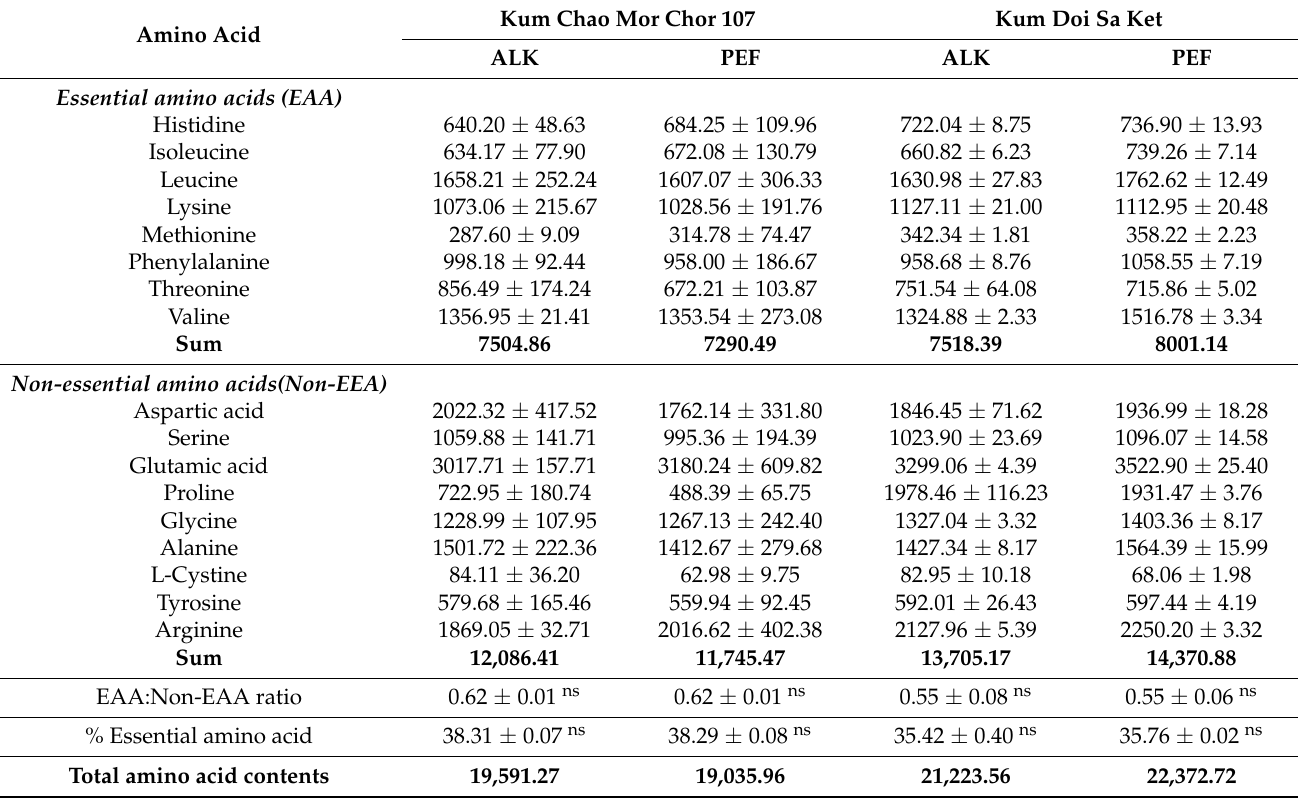
Table 2. Amino acid profiles of extracted rice bran proteins (mg/100 g